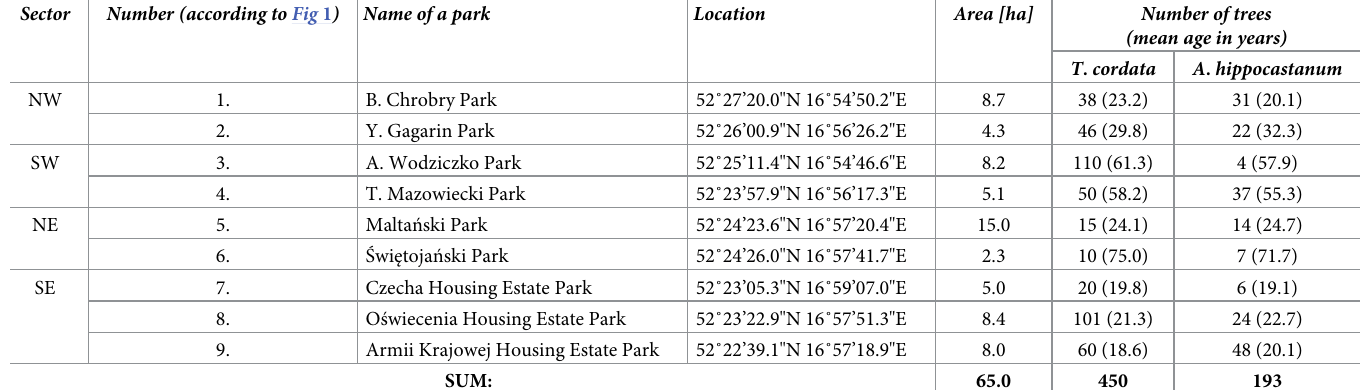
Table 1. Characteristics of the examined parks in Pozna ń .